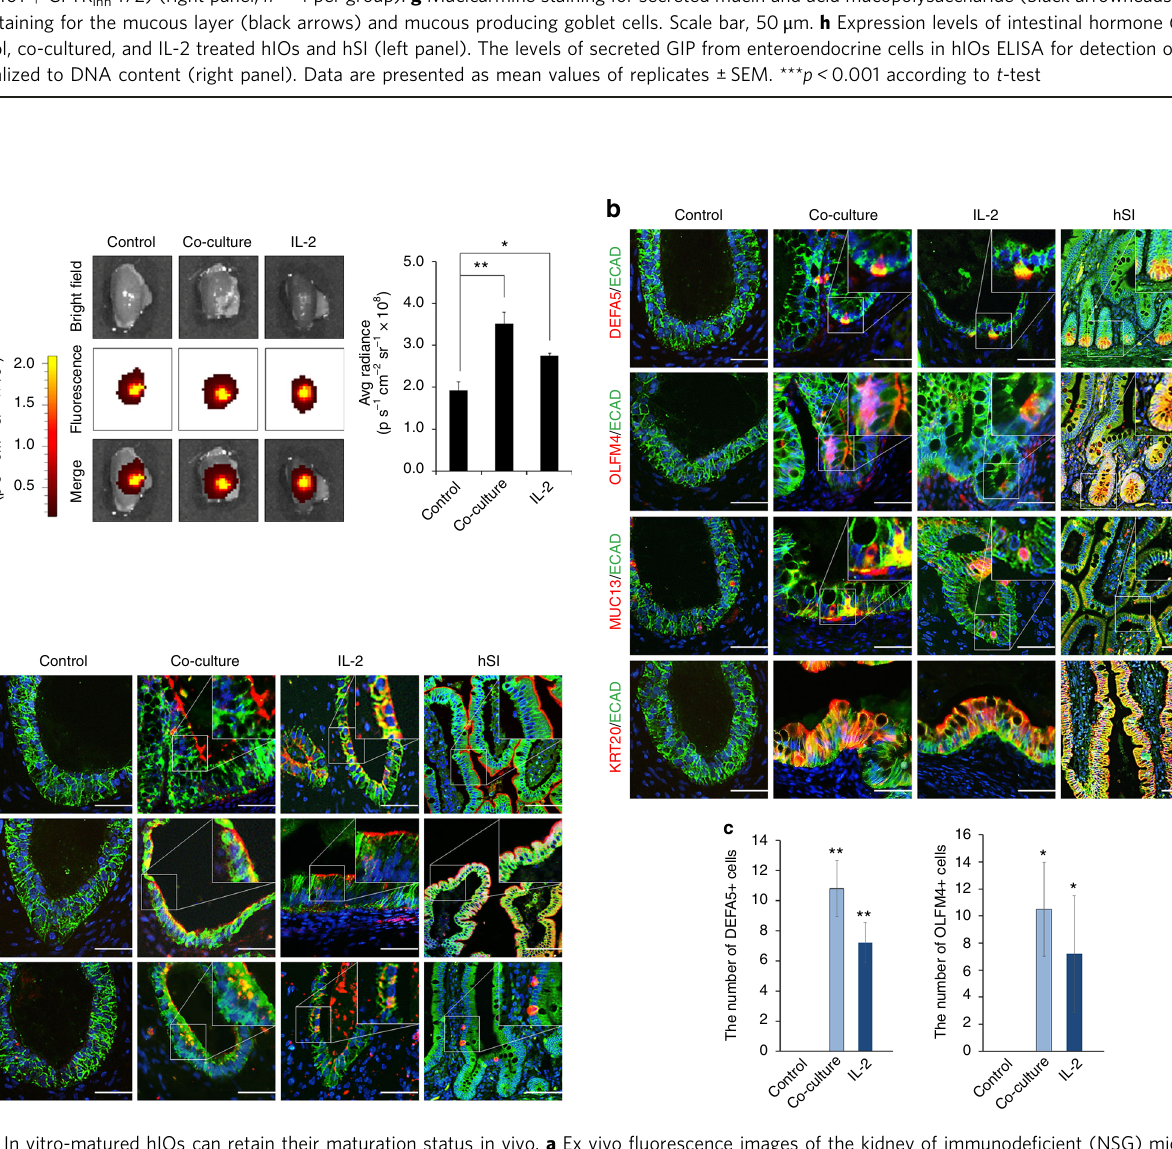
Fig. 5 In vitro-matured hIOs can retain their maturation status in vivo. a Ex vivo fl uorescence images of the kidney of immunode fi cient (NSG) mice transplanted with DiR-labeled hIOs 1 week after transplantation using an IVIS imaging system (left panels). Quanti fi cation of the fl uorescence intensity, expressed as the average radiance of the DiR-labeled hIOs (right panels; n = 3). p s − 1 cm − 2 sr − 1 , photons per second per cm 2 per steradian. b Immuno fl uorescent staining for the intestinal maturation markers DEFA5, OLFM4, KRT20 and MUC13 in control, co-cultured and IL-2-treated hIOs following transplantation. Adult human small intestine (hSI) tissues were used as controls. c The number of DEFA5 + and OLFM4 + cells in control, co- cultured and IL-2-treated hIOs. Expression of DEFA5 + cells (left panel; n = 5) and OLFM4 + cells (right panel; n = 4). d Immuno fl uorescent staining for the intestinal enzyme sucrase-isomaltase (SI) and intestinal transporters (peptide transporter 1, PEPT1; multidrug resistance protein 1, MDR1) in control, co- cultured and IL-2-treated hIOs following transplantation. hSI tissues were used as controls. Data are presented as mean values of replicates ± SEM. * p < 0.05 and ** p < 0.01 according to t